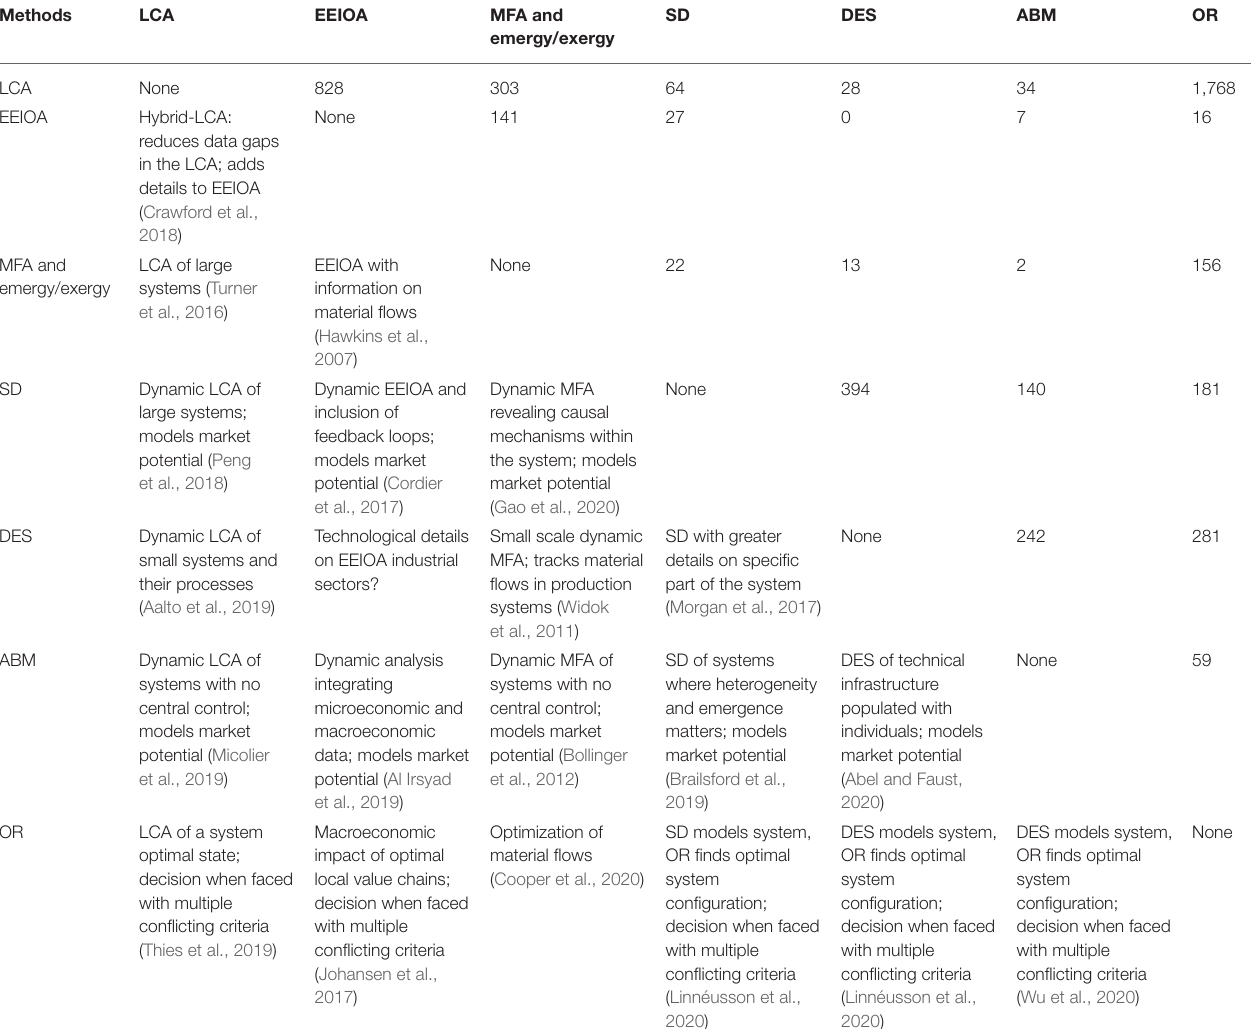
TABLE 1 | Types of analysis covered when combining methods (and example from the literature) and number of results in the scopus database with query string “TITLE-ABS-KEY [“Method 1” AND (“Method 2”)].